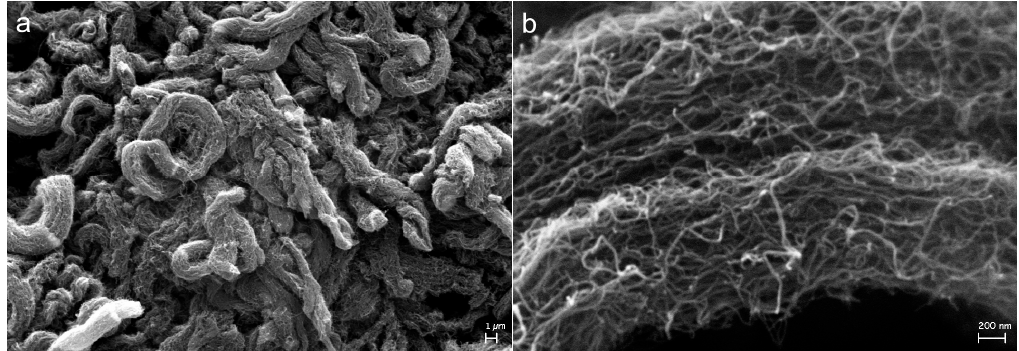
Figure 4. SEM micrographs of native MW ‐ CNTs: 2.5 ( a ) and 50 kx ( b ).